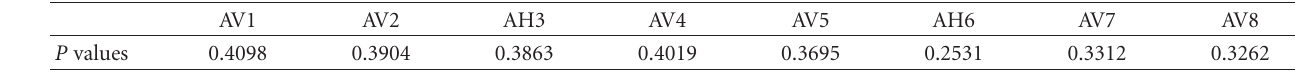
Table 1: P values for comparison of natural frequency distributions.